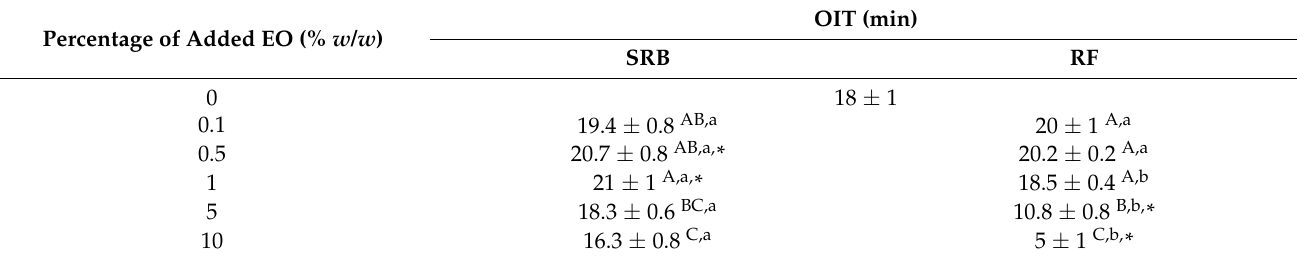
Table 6. Oxidation induction time (OIT) of sunflower oil with different share of added Russian (RF) and Serbian (SRB) essential